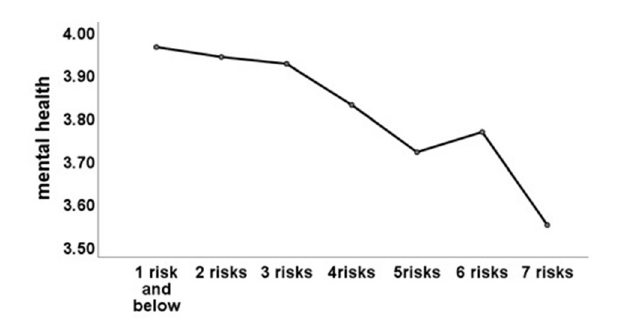
FIGURE1 Mental health and number of childhood family